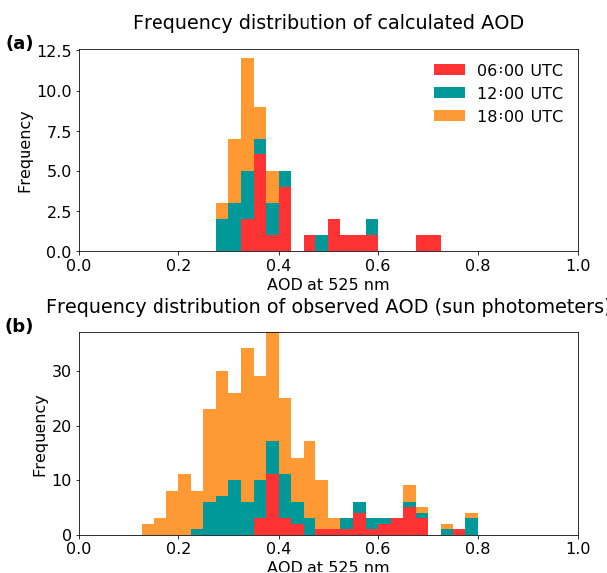
Figure 10. The frequency distributions of calculated AODs from ra- diosonde RHs, and AODs observed by sun photometers over Savé during the DACCIWA campaign. Bars shown here are stacked. Val- ues have not been calculated for 00:00UTC as this is during the